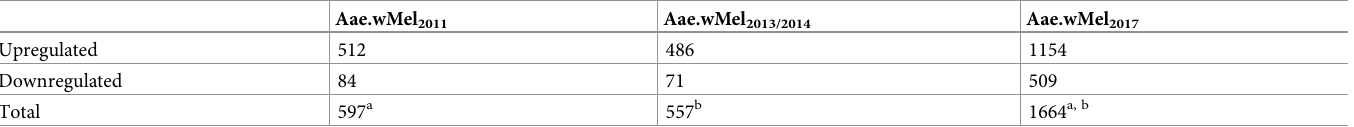
Table 2. Number of DEGs (absolute fold change ± 2 and adjusted P -value (false discovery rate (FDR)) � 0.05) in mosquitoes from populations with different w Mel release years versus Wolbachia -uninfected